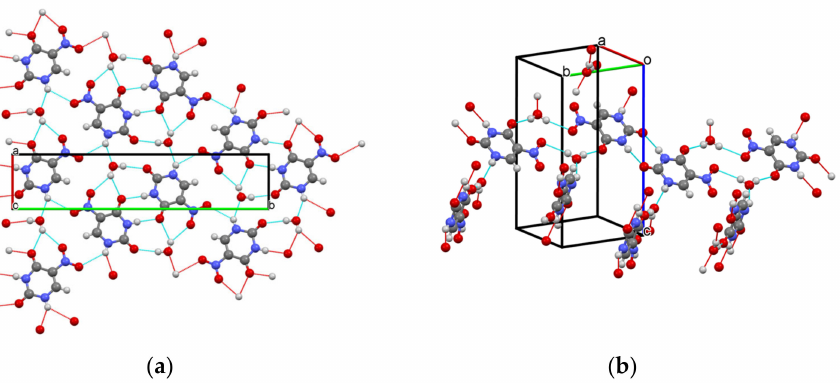
Figure 6. Hydrogen bond network in (IV) and (V) ( a ) H-bonded layers in (IV) ; ( b ) hydrogen bond network in (V)